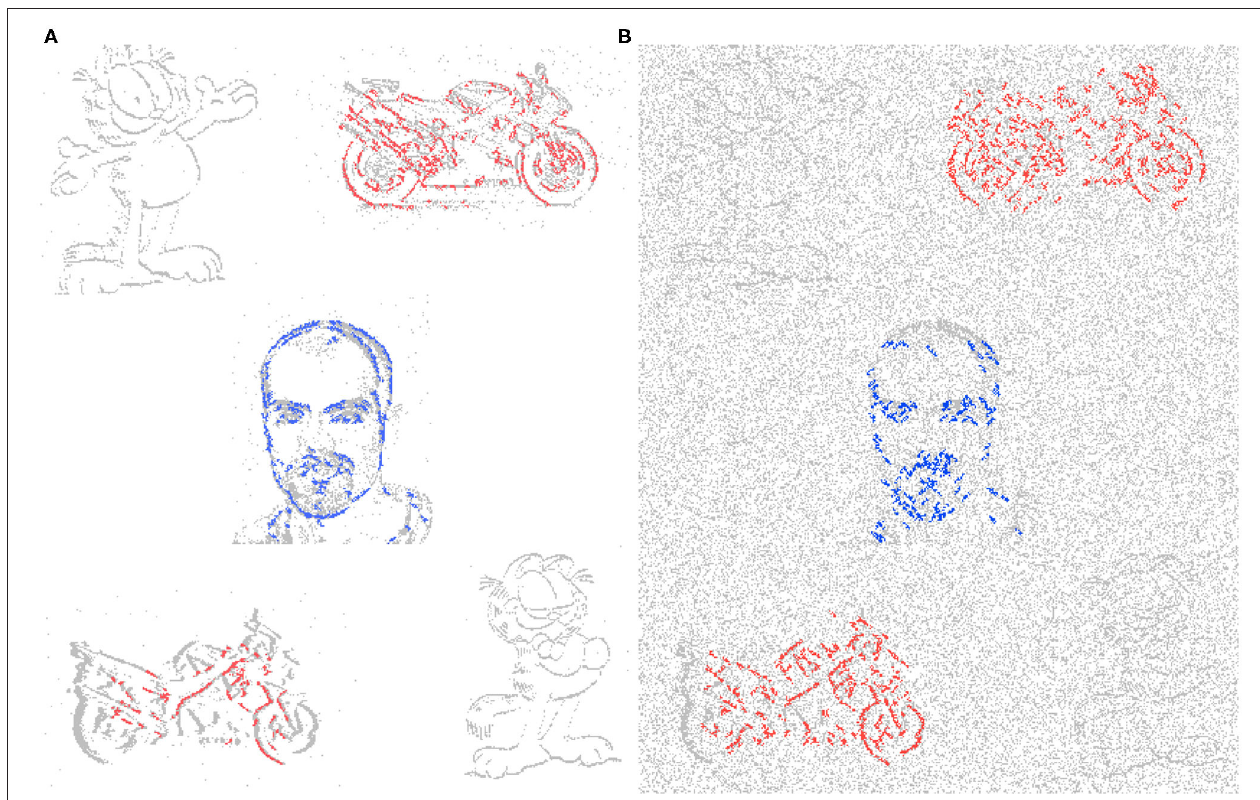
FIGURE 10 | Segmentation overlays for the (A) Multi-Stream Input and (B) Multi-Stream Input with noise, including the classes Face, Motorbike, and Garfield from the N-CalTech